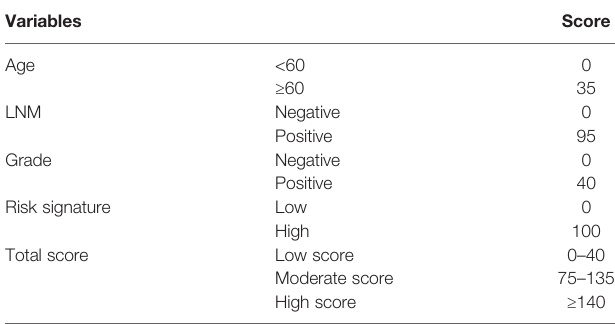
TABLE 3 | Corresponding risk score for each variable and total